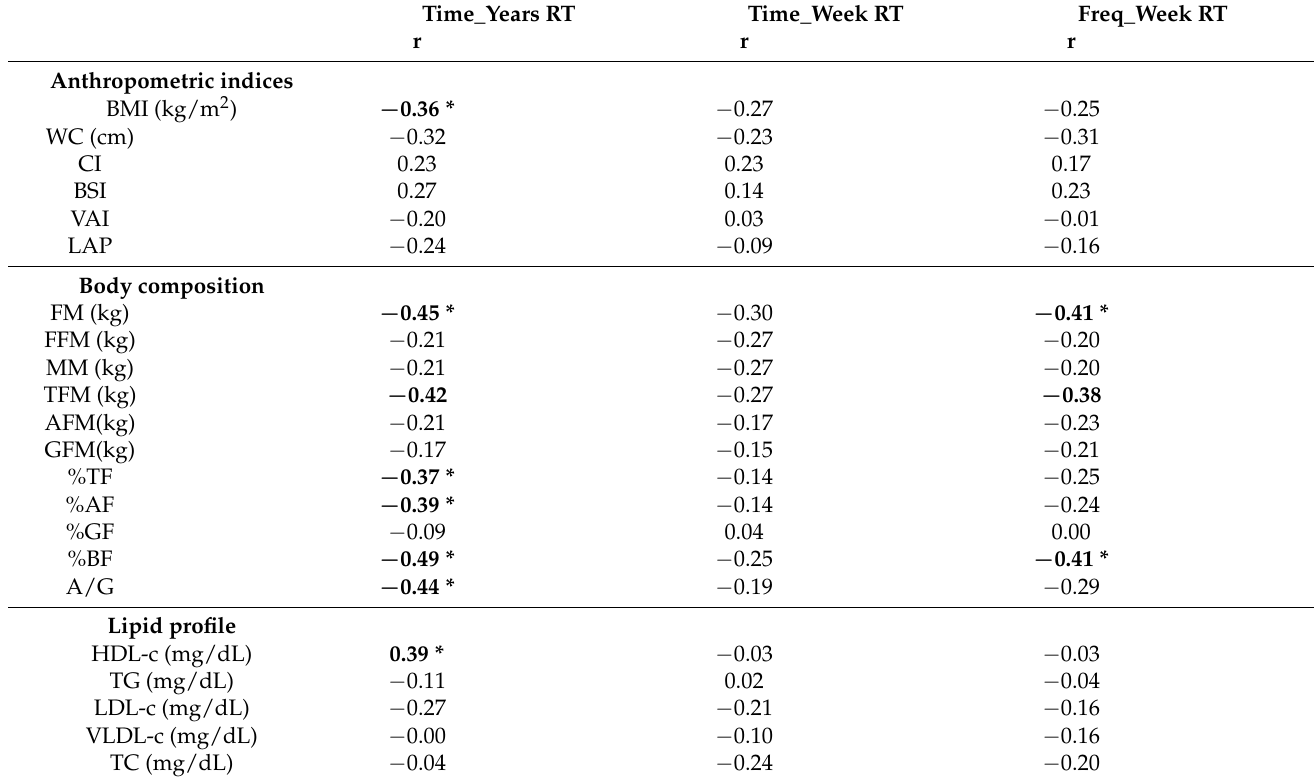
Table 4. Correlation between body and lipid variables, time in years, in minutes per week and weekly frequency of resistance training in the total sample.